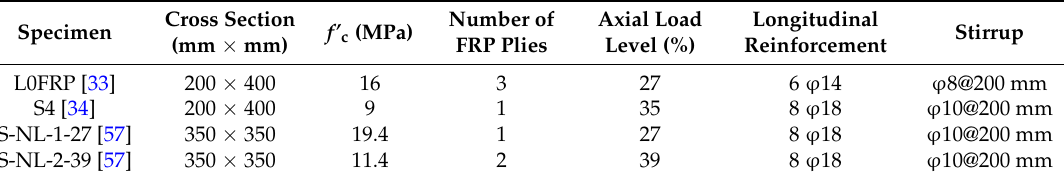
Table 14. The specifications of selected experimental specimens from the